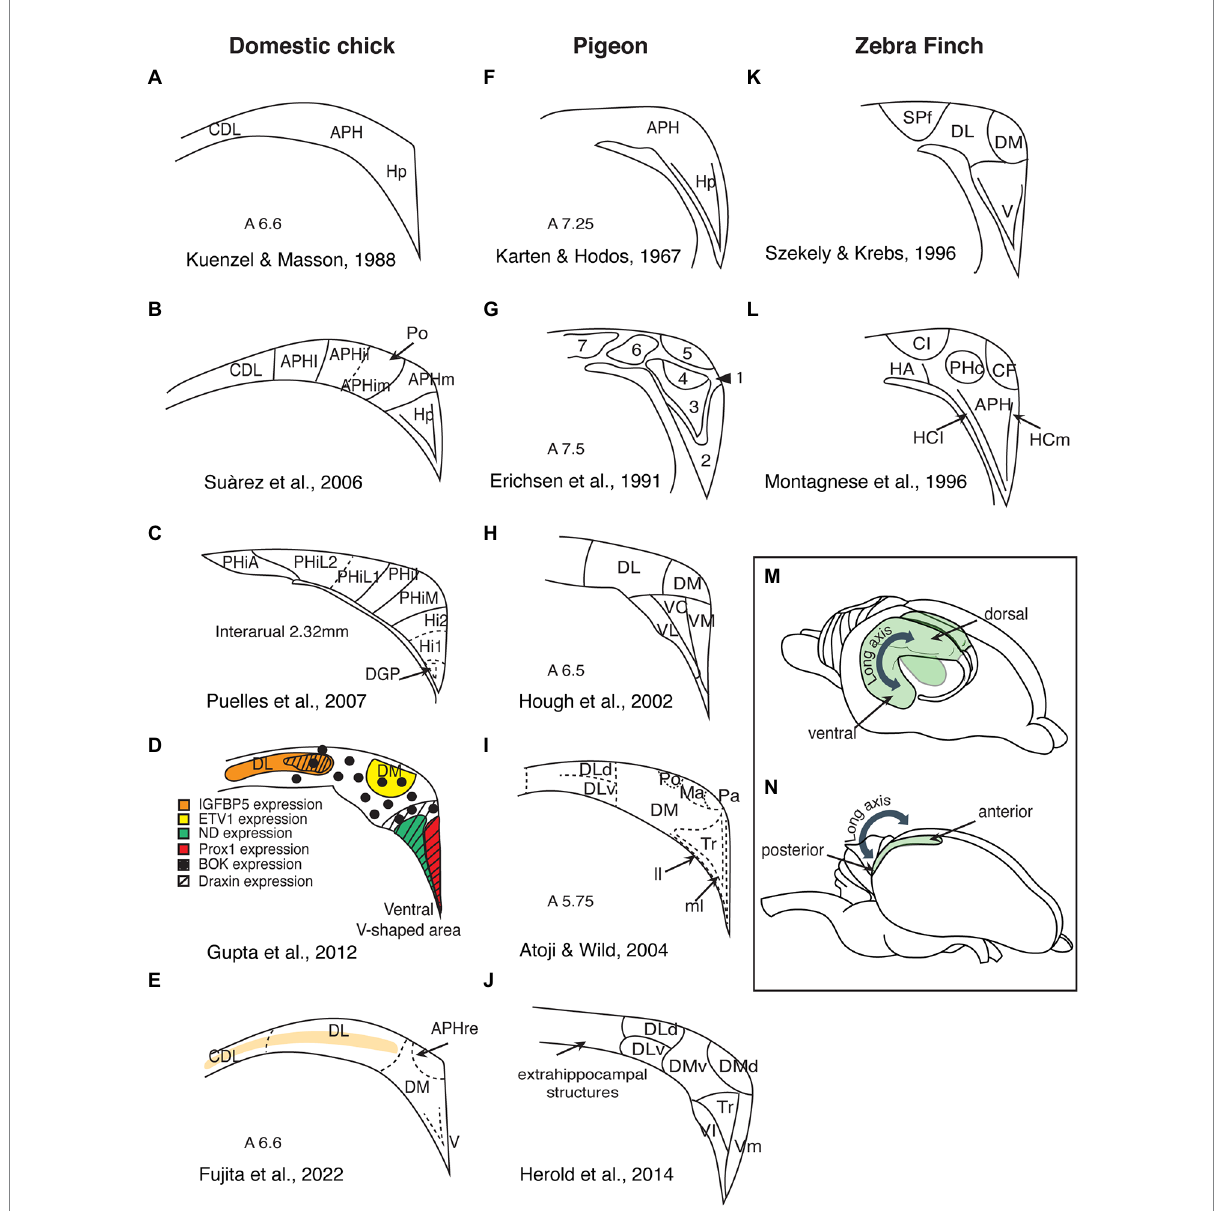
FIGURE 1 Summary of the different subdivisions proposed for birds hippocampal formation (schematic redrawing). (A–E) Domestic chicks; (F–J) Pigeons; (K,L) Zebra finches; (M) Side view of a rodent brain, showing the hippocampal organization along the dorsoventral axis (depicted in green). (N) Side view of an avian brain, showing the hippocampal organization along the anteroposterior axis. Hp, hippocampus; CDL, area corticoidae dorsolateralis; DM, dorsomedial; DL, dorsolateral; DLd, dorsal portion of the dorsolateral hippocampal formation; DLv, ventral portion of the dorsolateral hippocampal formation; V, ventral; VL, ventrolateral; VC, ventrocentral; VM, ventromedial; Vl, ventrolateral; Vm, ventromedial; APH, parahippocampal area; APHre, ectopic part of the rostral area parahippocampalis; APHl, lateral parahippocampal area; APHil, lateral part of the intermediate parahipocampal area; APHim, medial part of the intermediate; APHm, medial parahippocampal area; Po, cell-poor region of the hippocampal formation; PHiA, parahipp area, apical; PHiL2, parahipp area, lat 2; PHiL1, parahipp area, lat 1; PHiI, parahipp area, intermed; PHiM, parahipp area, medial; Hi1, hippocampus proper part 1; Hi2, hippocampus proper part 2; DGP, dentate gyrus primordium; Tr, triangular region of the V-shaped hippocampal layer; ll, lateral layer of the V-shaped hippocampal layer; ml, medial layer of the V-shaped hippocampal layer; Ma, magnocellular region of the hippocampal formation; Pa, parvocellular region of the hippocampal formation; SPf, Substance P-immunoreactive nucleus; CL, intermediate corticoid area; HA, apical hyperpallium; PHc, central field of the parahippocampus; CF , crescent field; HCl, lateral hippocampus; and HCm, medial